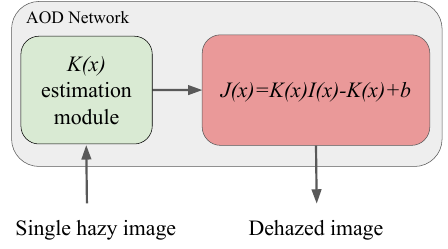
Figure 4: The General Structure Of AOD-Net